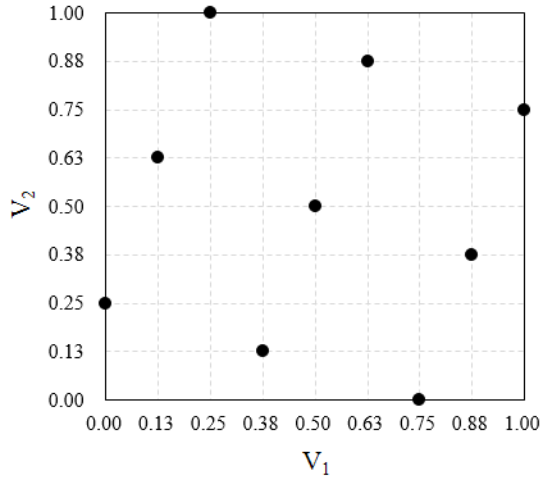
Figure 6. Example of conventional LHS.